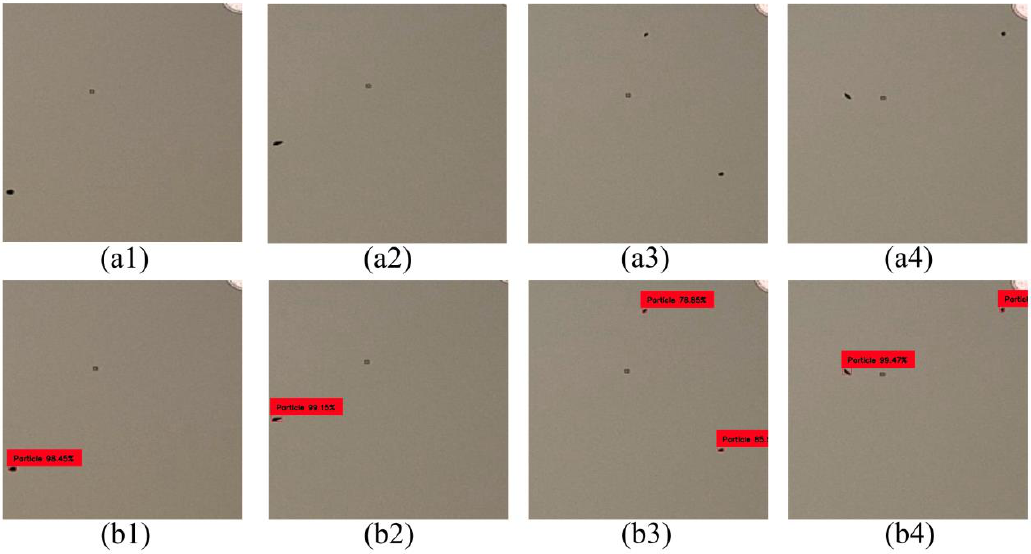
Figure 7. Defect detection results by GAN + YOLOv3. ( a1–a4 ) Images to be inspected and ( b1–b4 ) detection results.